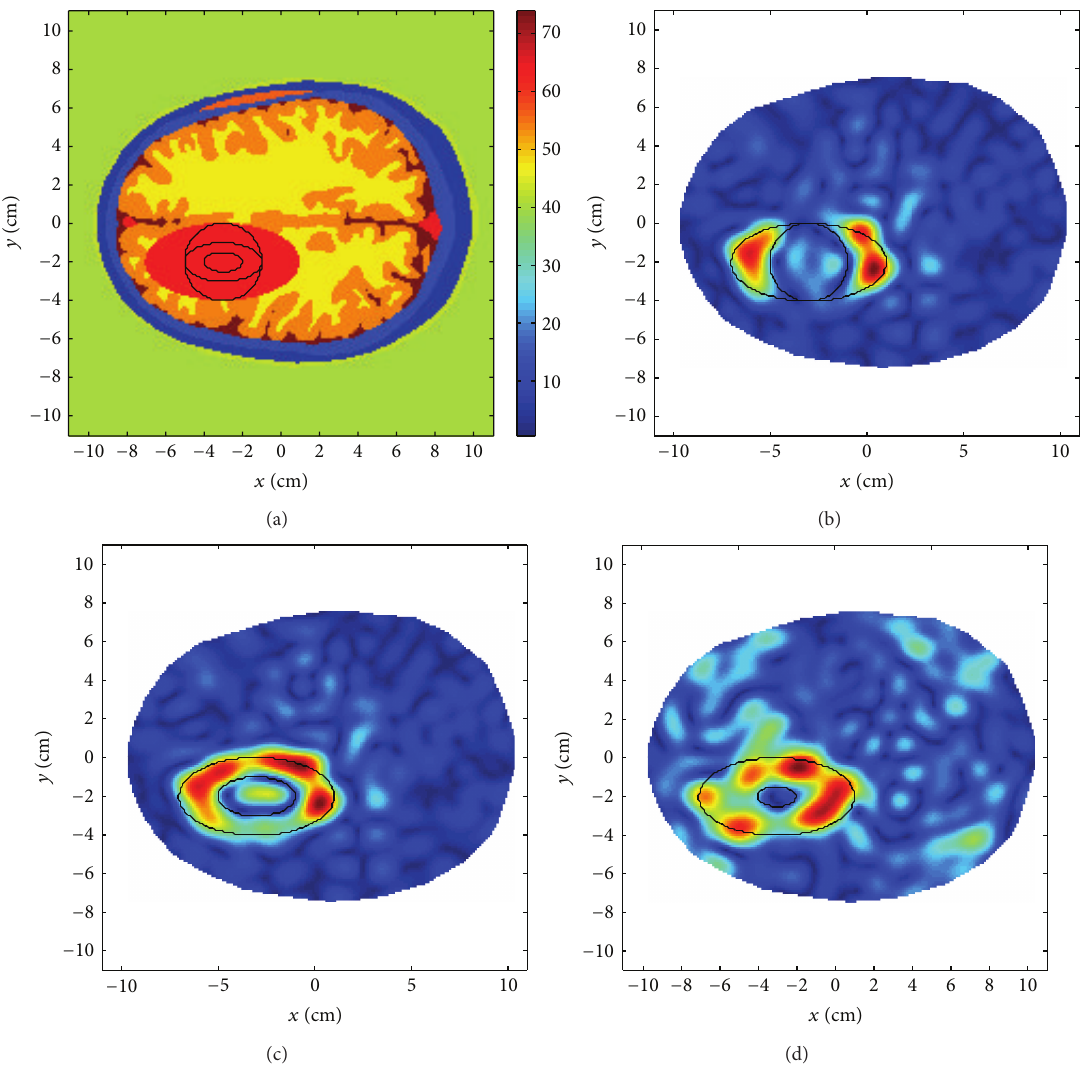
Figure 6: Followup of a postdiagnosis evolution of a hemorrhagic brain stroke via the proposed differential TSVD imaging approach in realistic conditions. (a) Scenario at the time 𝑡 0 (stroke diagnosis). The stroke is the red ellipse, while black contours represent its evolution at times 𝑡 1 , 𝑡 2 , and 𝑡 3 ; (b) normalized amplitude of the retrieved contrast at time 𝑡 1 ; (c) as (b) but at time 𝑡 2 ; (d) as (b) but at time 𝑡 3 . A gaussian noise with SNR = 70 dB and a 2 ∘ displacement of the probes has been assumed. The nonspecific reference head model is adopted in the